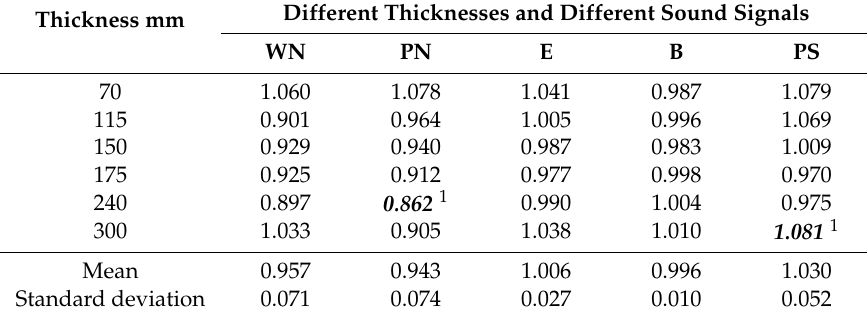
Table 3. Calculated weighted normalized loudness level differences. The different signal types are indicated by PN for pink noise, WN for white noise, B for Beethoven, E for Eminem, and PS for Party Sound.